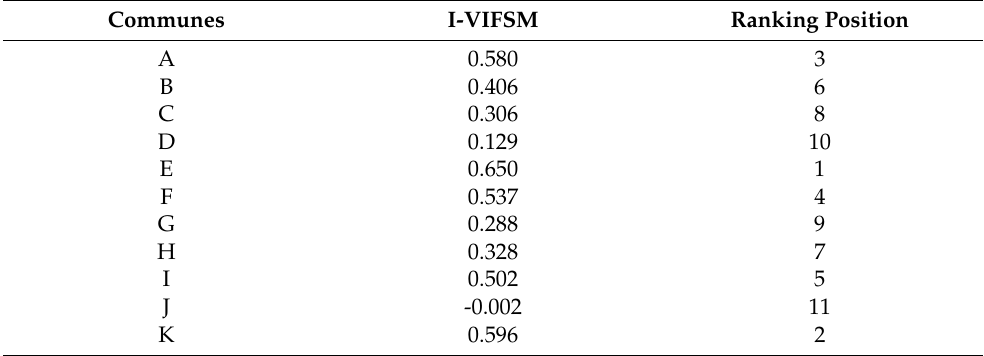
Table 14. I-VIFSM values for